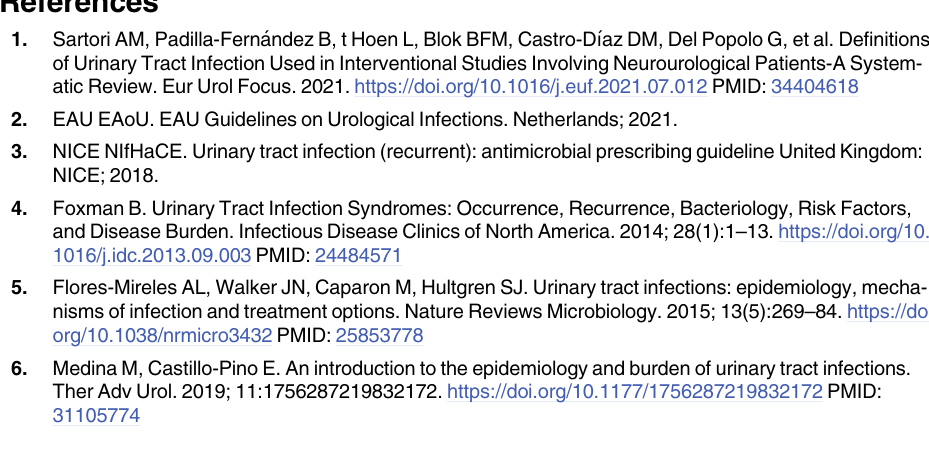
S4 Table. Quality of psychometric results Terwee et al. [37]. S5 Table. Kappa score. S6 Table. Detailed comparison of knowledge and attitudes